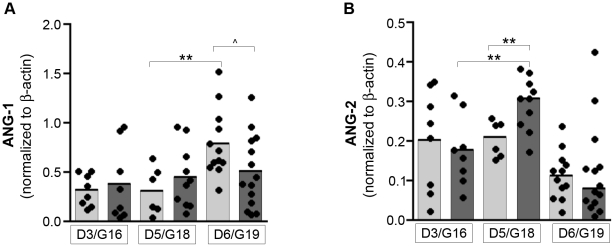
Placental ANG-1 and ANG-2 protein levels are dysregulated by malaria infection.
(A) ANG-1 and (B) ANG-2 protein levels in placentas from pregnant mice uninfected (light bars) and infected with P. berghei (dark bars). Protein levels were detected by Western blot, quantified by densitometry and normalized to intensity of β-actin bands. Dots are individual placentas associated with viable fetuses; bars represent the median of each group. 3–13 mice are represented per group. **P<0.01, ∧ P = 0.053 (unpaired t-test). D, day post infection/control injection; G, gestational day.